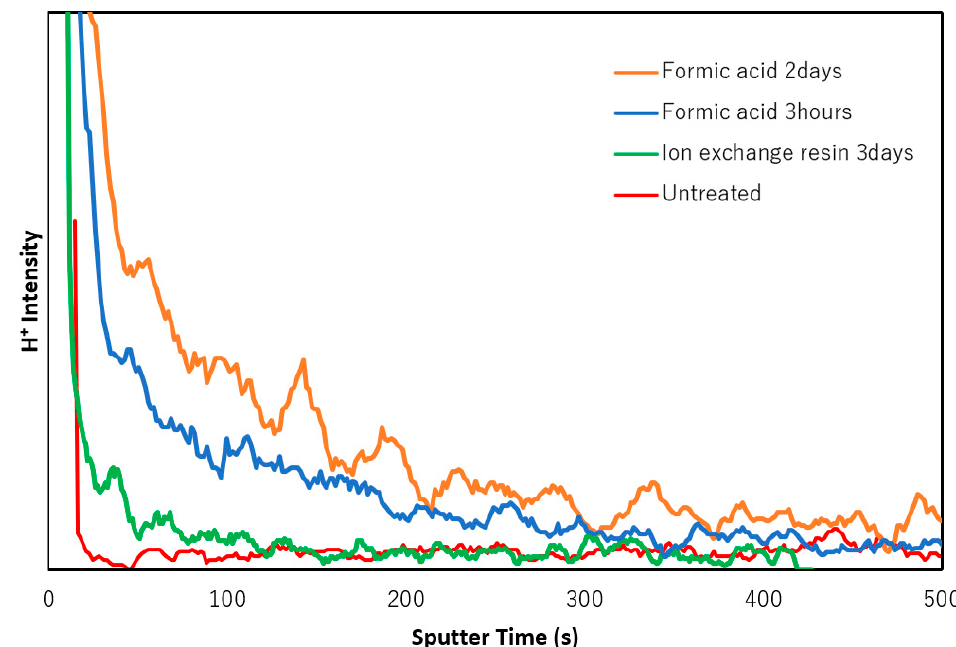
Figure 3. TOF-SIMS analysis of H + species distribution in thin films: untreated thin film (red line), thin film treated by ion-exchange resin for 3 days (green line), thin film treated by formic acid for 3 h (blue line), and thin film treated by formic acid for 2 days (orange line).